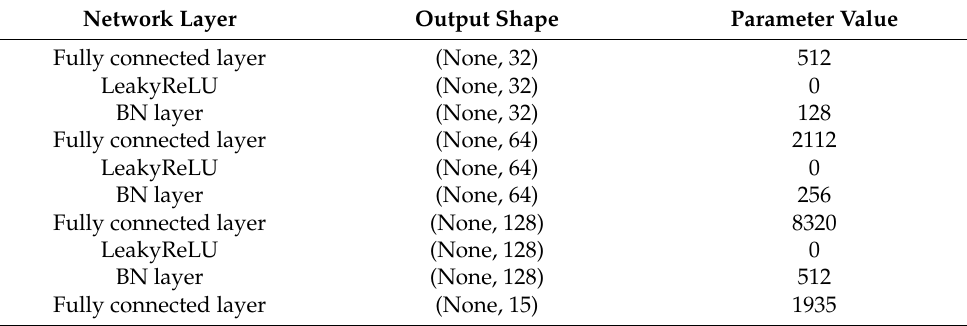
Table 1. Generator network